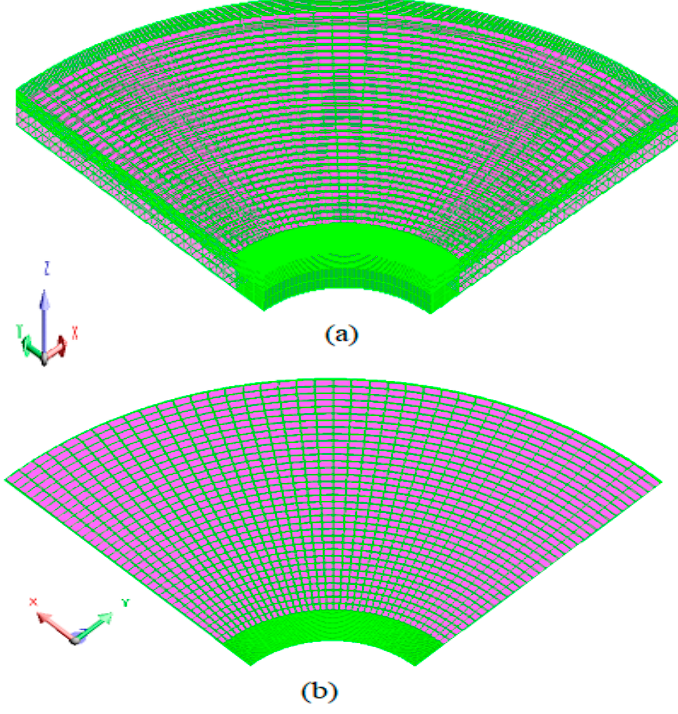
Figure 3. Finite element mesh: ( a ) Three-dimensional (3D) view ( b ) top view.